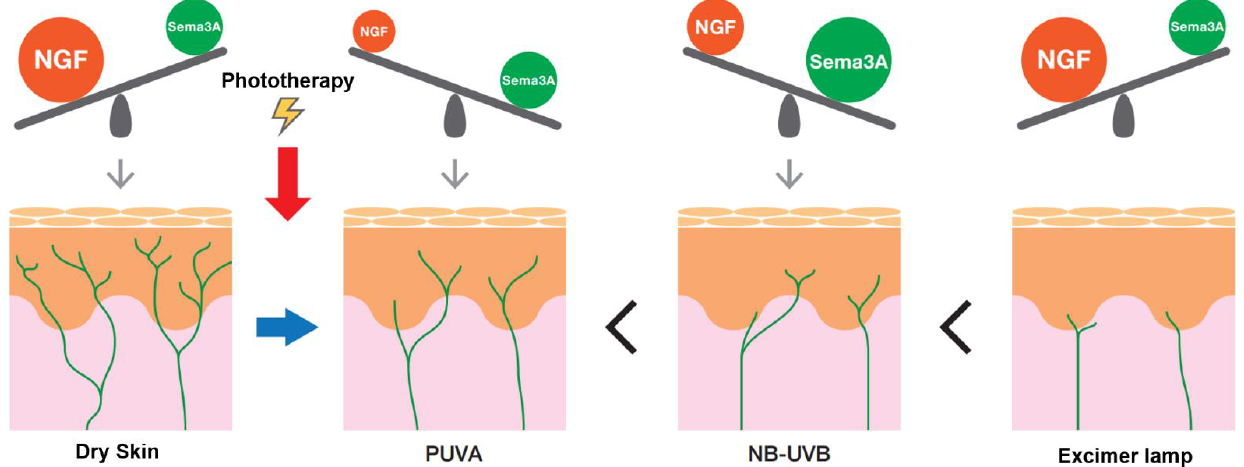
Figure 4. Antipruritic mechanism of phototherapy. In dry skin, the up-regulated expression of NGF and down-regulated expression of Sema3A increase the number of IENFs. When various types of phototherapy are used for dry skin, they inhibit IENF hyperplasia in the order of PUVA therapy < NB-UVB < excimer lamps. The inhibitory effects of PUVA and NB-UVB therapy on IENF proliferation are due to the down-regulated expression of nerve elongation factors and up-regulated expression of nerve repulsion factors in keratinocytes; however, excimer lamps act directly on IENFs and induce neurodegeneration without altering the expression of these axon guidance molecules.